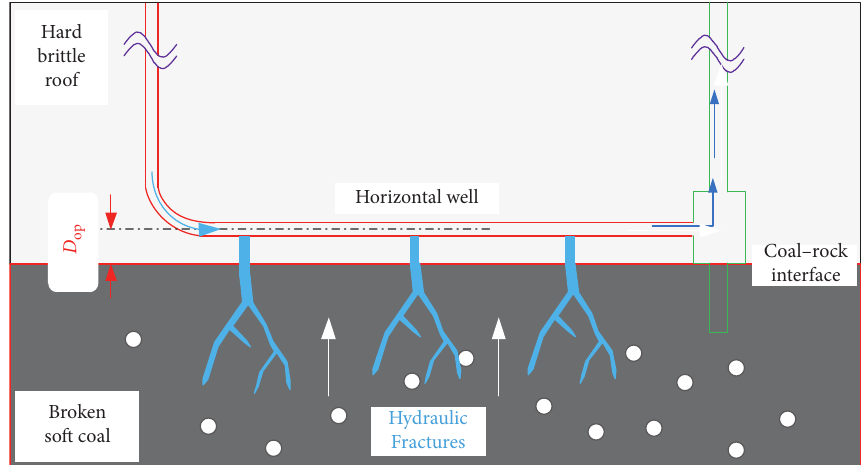
Figure 2: Schematic diagram of indirect fracturing coal